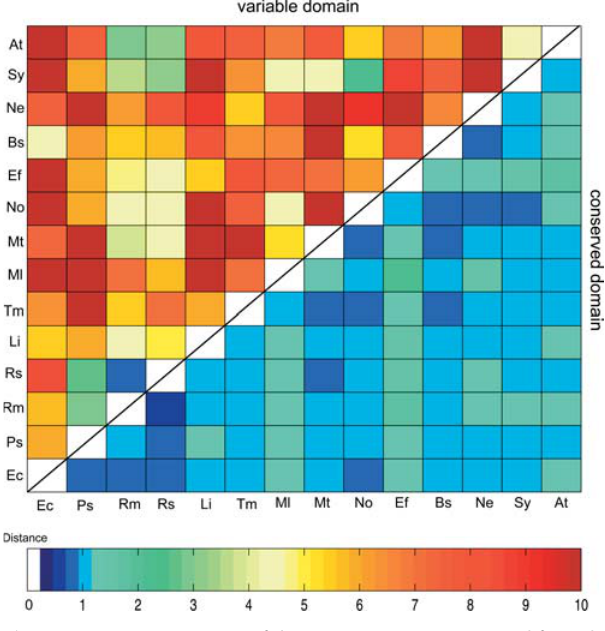
Figure 3. 2D Representation of the Distance Matrix Computed from the Variable and Conserved Domains in a Group of Similar HKs The upper triangle shows the variable domains, the lower one the conserved domains. Amino acid sequence distances are calculated by the PROTDIST program using the Dayhoff PAM matrix. The sequence from each species is the best match ( E -value , 1 E -10) in that genome to the query E. coli gene. Abbreviations for organisms: Ec, Escherichia coli K12; Ps, Pseudomonas syringae pv. syringae B728a; Rm, Ralstonia metallidurans ; Rs, Ralstonia solanacearum ; Li, Listeria innocua ; Tm, Thermotoga maritime ; Ml, Mycobacterium leprae ; Mt,